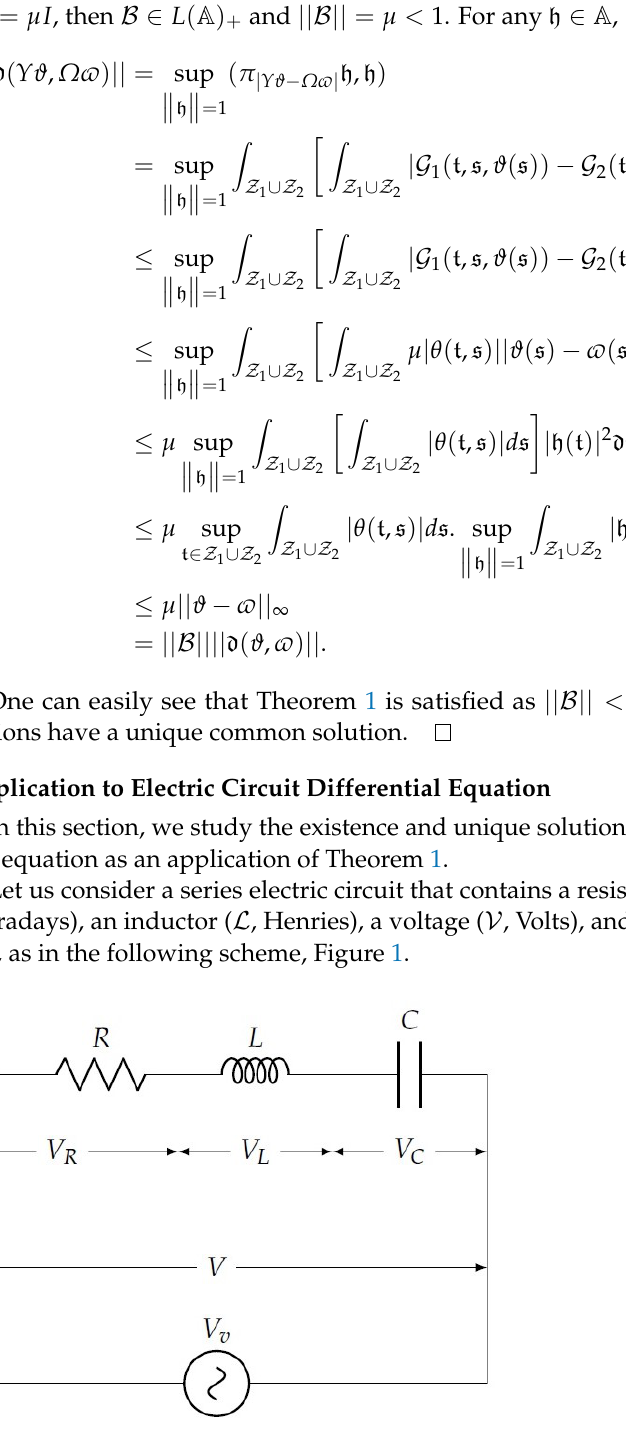
Figure 1. RLC circuit in